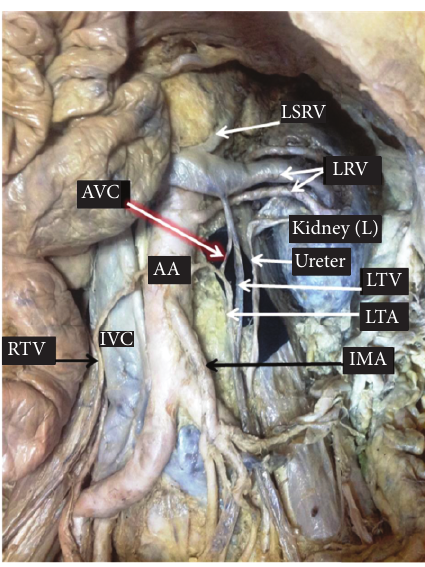
Figure 1: Showing presence of arteriovenous communication (AVC) between left testicular artery (LTA) and Left testicular vein (LTV). Right testicular vessels (RTV) were found to be normal. LRV: left renal vessels, LSRV: left suprarenal vein, IMA: inferior mesenteric artery, RTV: right testicular vessels, AA: abdominal aorta, and IVC: inferior vena